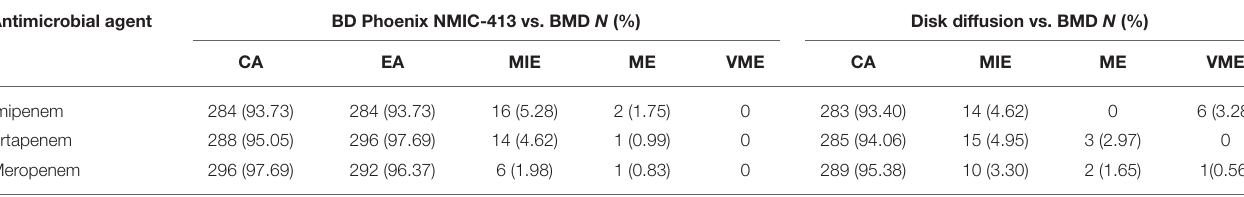
TABLE 2 | Performance of the BD Phoenix NMIC-413 and disk diffusion compared with BMD for Enterobacterales isolates. Antimicrobial agent